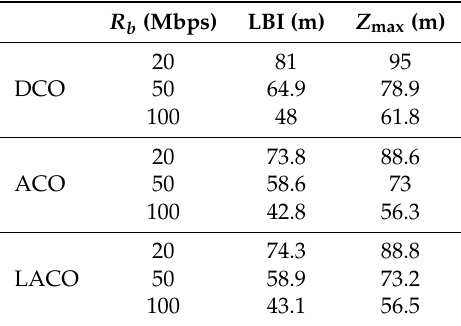
Figure 9. BER as a function of Z for ACO-, LACO-, and DCO-OFDM, with P Tx,e = 50, 80, and 185mW, respectively. R b = 20, 50, and 100Mbps; N and N CP as in Figure8, η ≈ 1bps/Hz. The corresponding LBIs and Z max are summarized in Table 4 for a target BER of 10 − 3 . Table 4. LBI and maximum attainable range for DCO, ACO, an LACO-OFDM transmission schemes according to Figure9; BER = 10 − 3 , η ≈